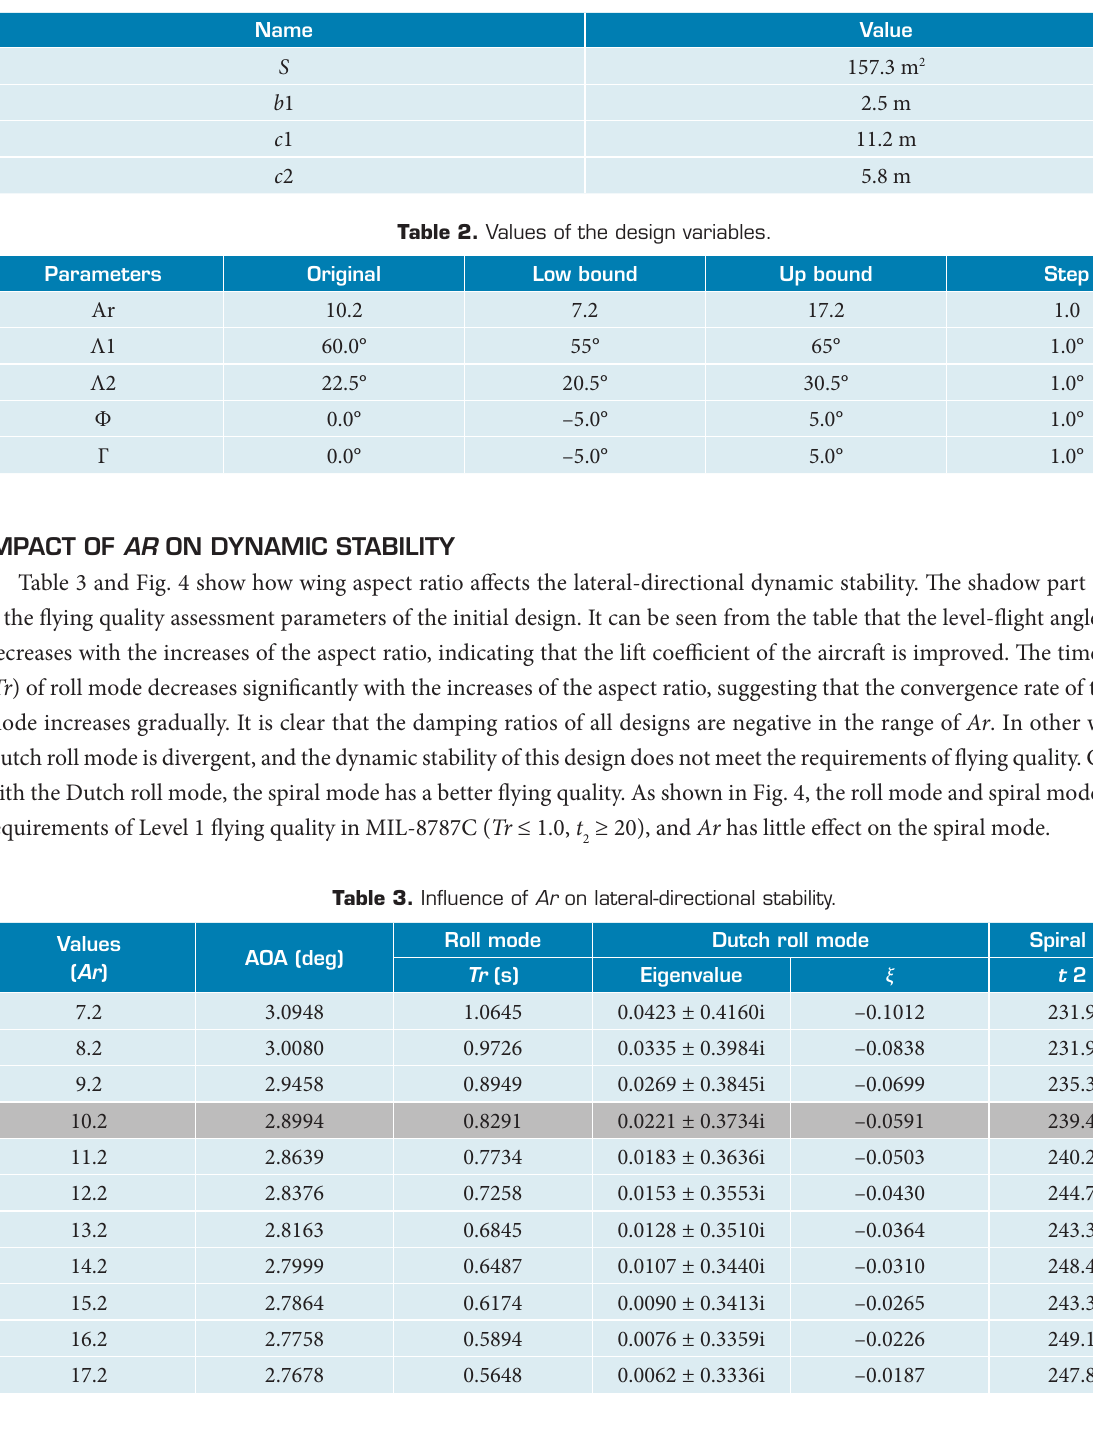
Table 1. Values of the design parameters.